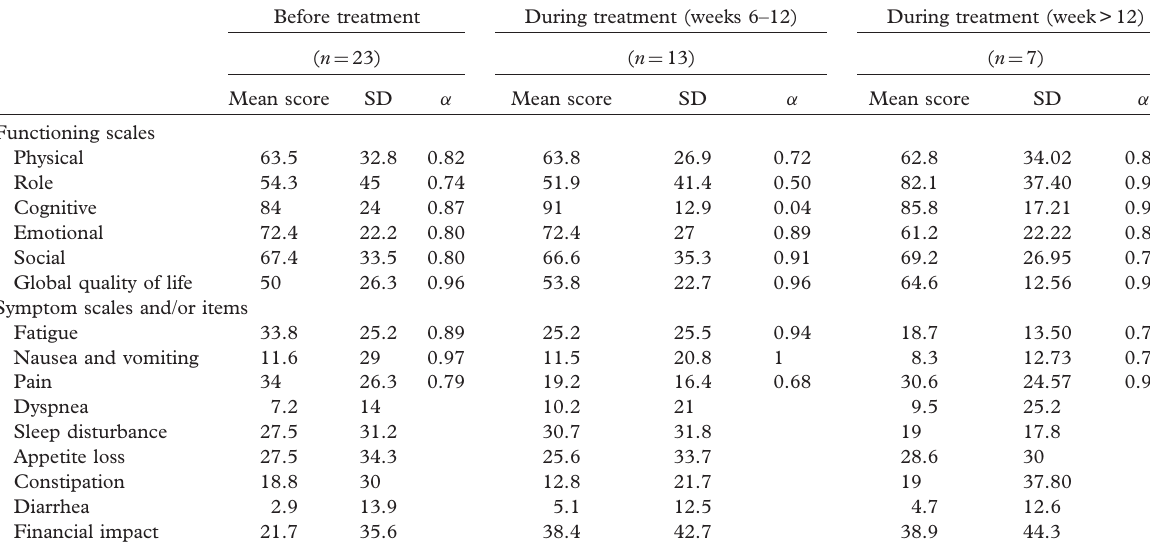
Table III. Score of the EORTC QLQ-C30 before and during treatment. Before treatment During treatment (weeks 6–12) During treatment